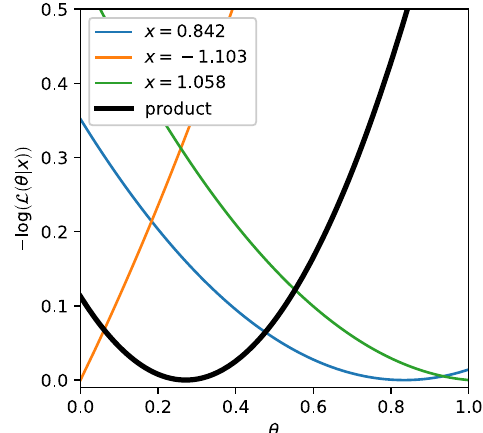
Fig. 6 For a fixed value of the parameter θ = 0 . 2, three x i values are generated. The posteriors ˜ p i (θ | x i ) are obtained from the output of the trained MDN of Sect. 5.2. The maximum likelihood estimator θ ML is extracted from the product of these posteriors according to Eq. (10) and shows a result statistically compatible with the expected value of 0.2. (For visualization, all functions are offset to have a minimum of 0)